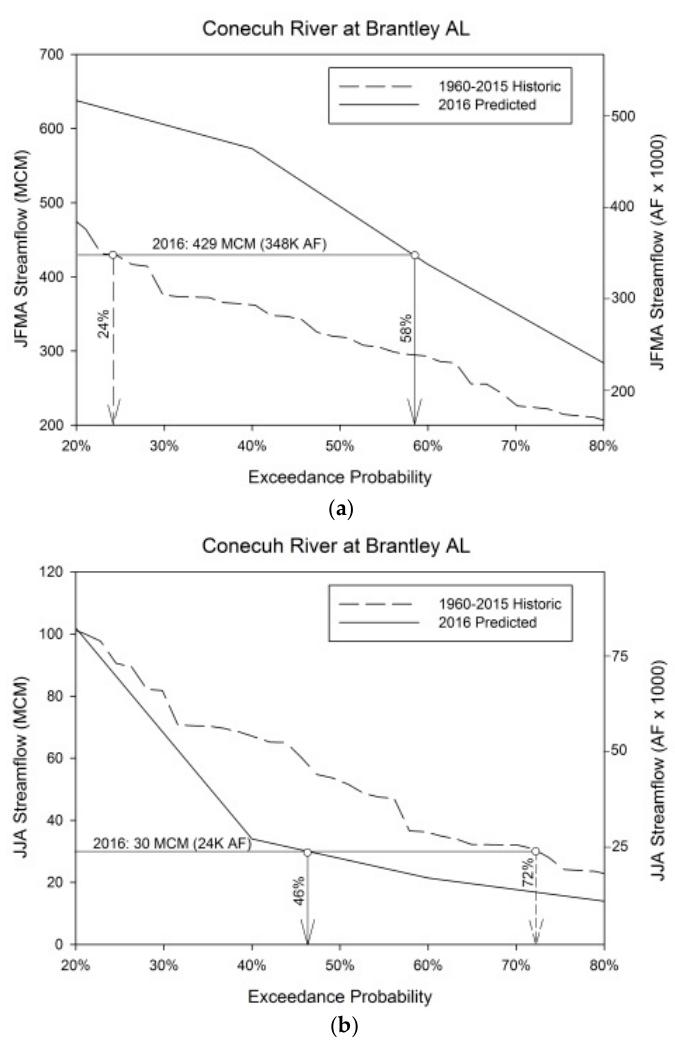
Figure 4. Observed (long-term average) and predicted (using historic El Niño events) exceedance probability curves for ( a ) winter-spring (JFMA) and ( b ) summer (JJA) seasonal streamflows for the Conecuh River. The observed 2016 streamflow for each season and corresponding exceedance probability is provided.